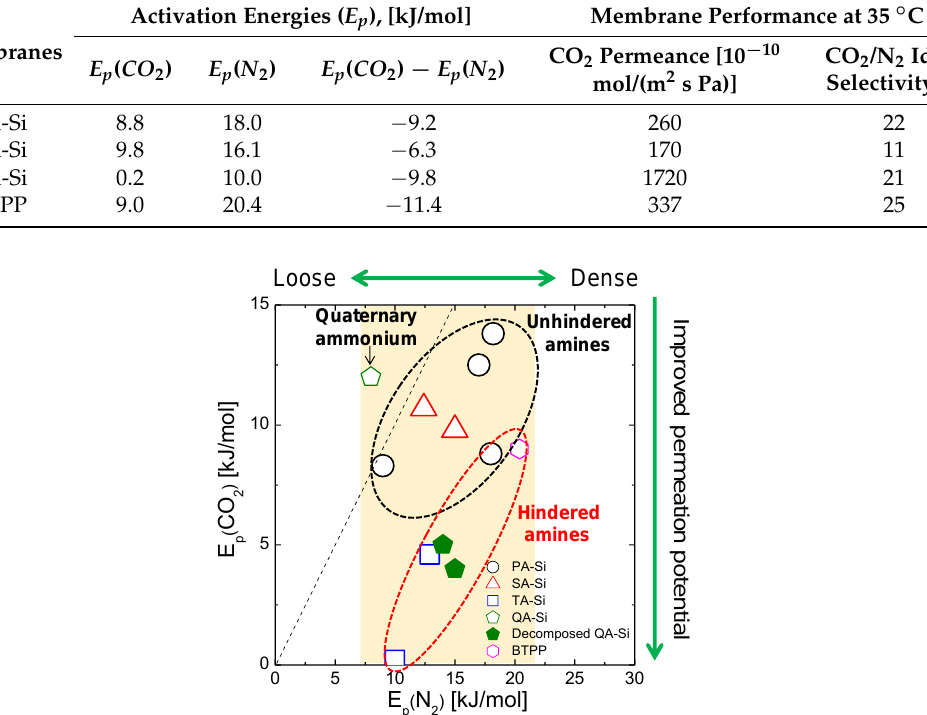
Table 5. Values for E p and CO 2 /N 2 separation performance at 35 ◦ C for amine-functionalized organosilica membranes. Results were reorganized from refs. [21,22].